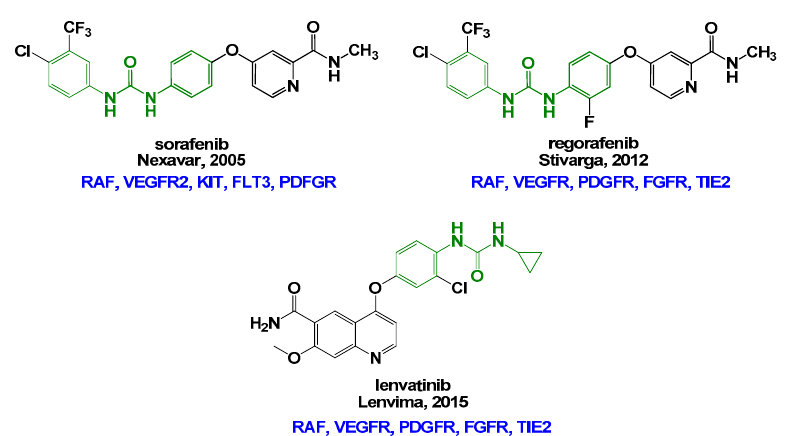
Figure 3. FDA-approved kinase inhibitors containing unsymmetrically disubstituted urea. The urea fragments are colored green. INN, brand name, year FDA approved, and main target kinases are provided for each kinase drug. Kinase abbreviations: RAF: rapidly growing fibrosarcoma; FLT3: Fms-like tyrosine kinase 3; FGFR: fibroblast growth factor receptor; TIE2: tyrosine kinase with immunoglobulin and epidermal growth factor homology domains 2.